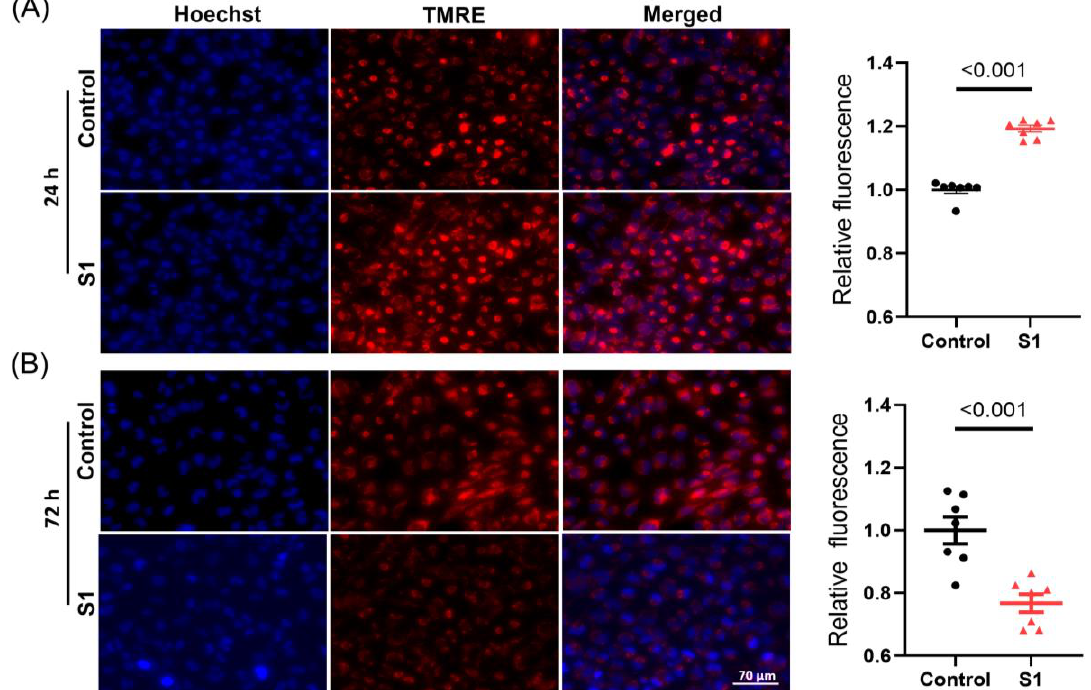
Figure 2. AC16 mitochondrial membrane potential was evaluated using TMRE staining after 24 h and 72 h S1 treatment. S1 increased AC16 mitochondrial membrane potential after 24 h treatment compared to the control group ( A ). However, after 72 h treatment, S1 decreased mitochondrial membrane potential in AC16 cells ( B ). n = 7 independent experiments. Paired t -test was used for comparing the difference in TMRE fluorescence between groups. TMRE: tetrametylrhodamine ethyl ester.